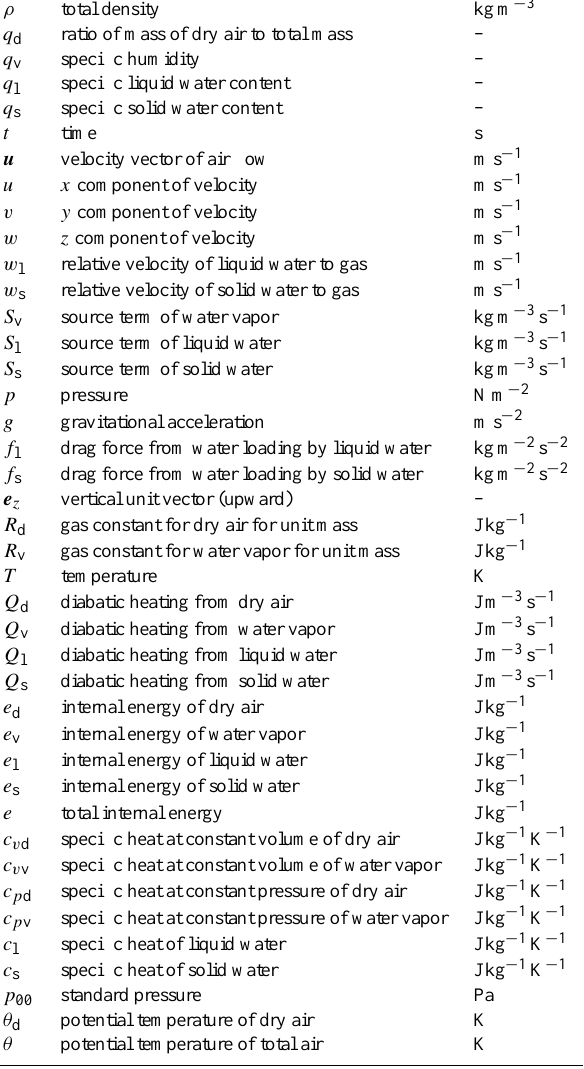
Table 1. Notation of